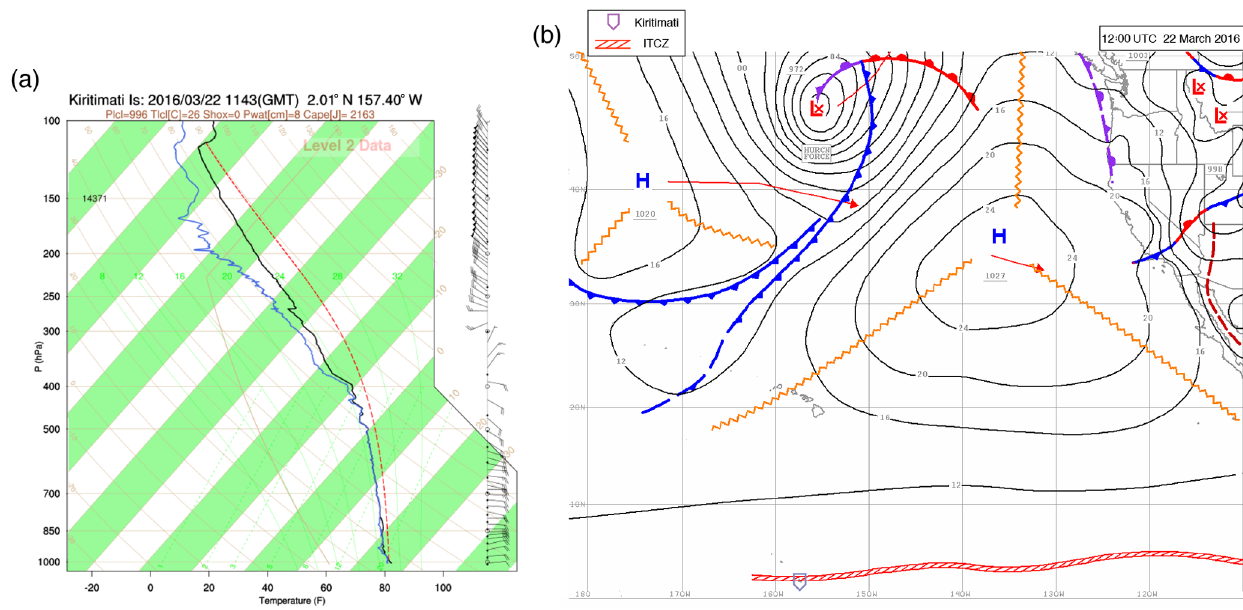
Figure 11. The 22 March 2016, 12:00UTC sounding, the wettest one collected at CXENRR, was launched while the ITCZ was located over